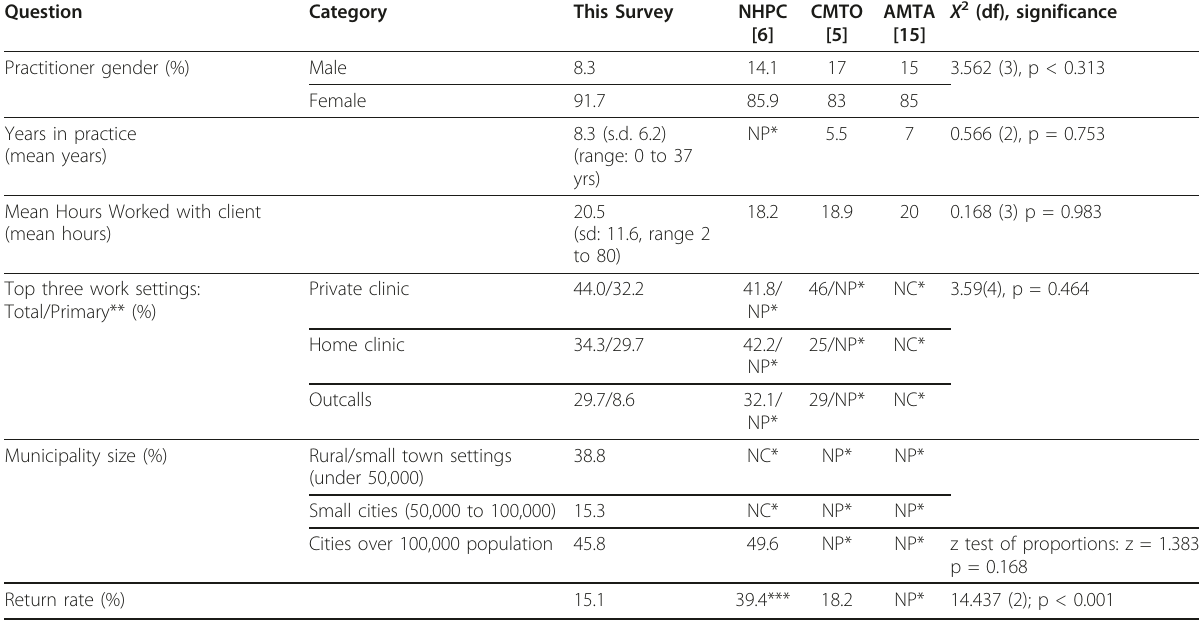
Table 2 Demographic characteristics, and comparison to past